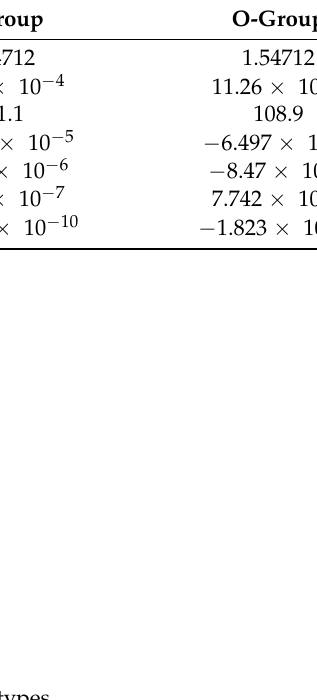
Table 2. Model coefficients.